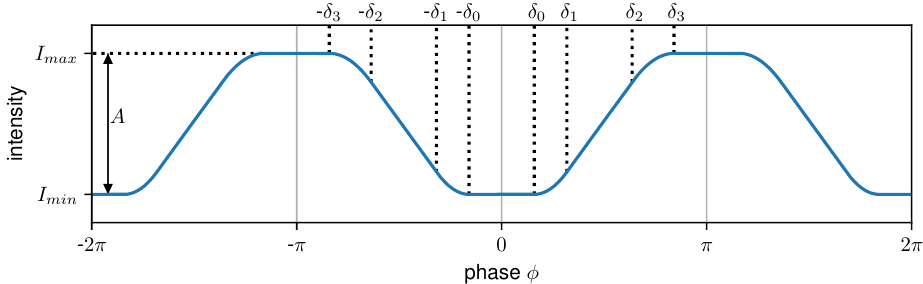
Figure 2. An example of the piecewise-defined periodic polynomial (PP) function I PP for ∆ φ = 0. Between 0 and δ 0 , respectively, δ 3 and π I PP has a constant value of I min and I max , respectively. For phase values between δ 0 and δ 1 , respectively, δ 2 and δ 3 I PP is parabolic while it is linear between δ 1 and δ 2